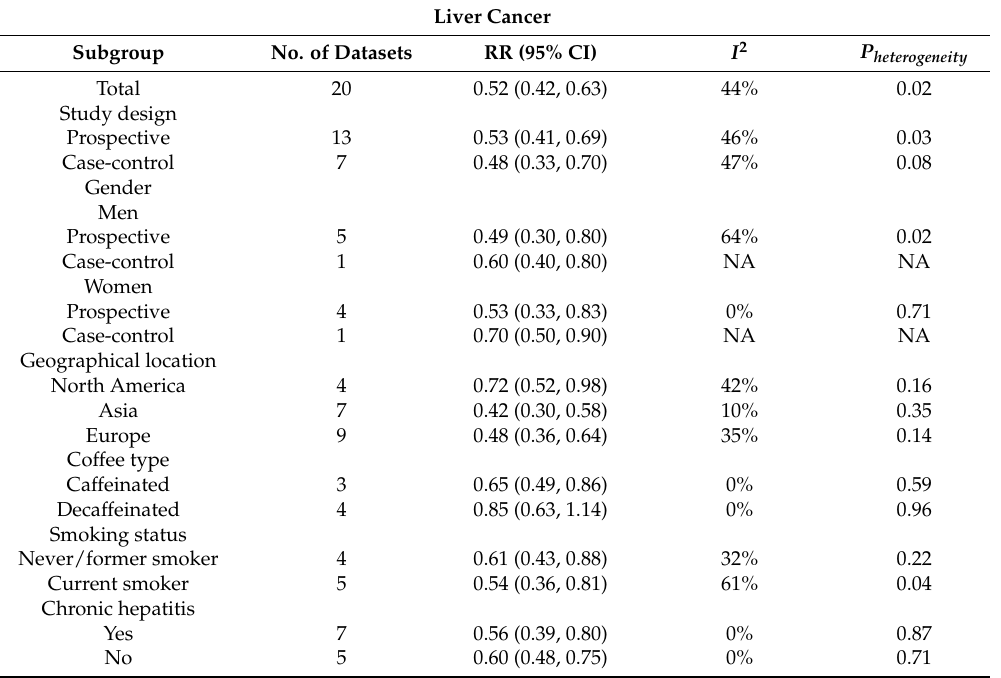
Table 2. Subgroup analyses of studies reporting risk of liver cancer for the highest versus lowest (reference) category of coffee consumption.